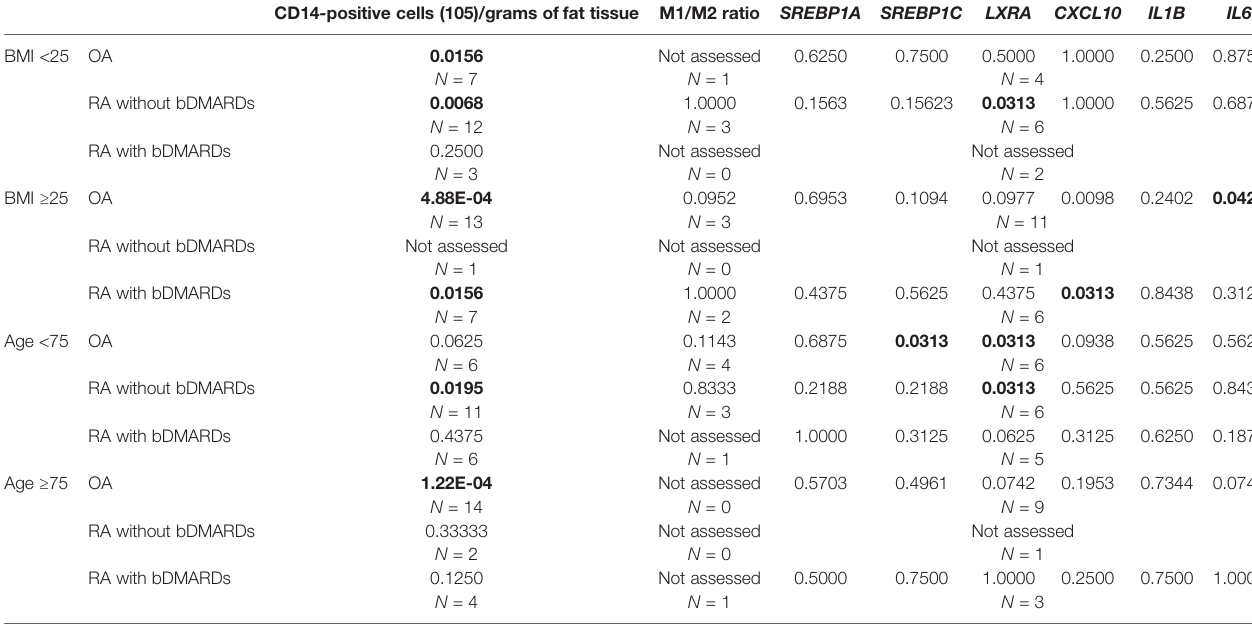
TABLE 3 | Impact of body mass index (BMI) and age category of osteoarthritis (OA) and rheumatoid arthritis (RA) patients on the related gene